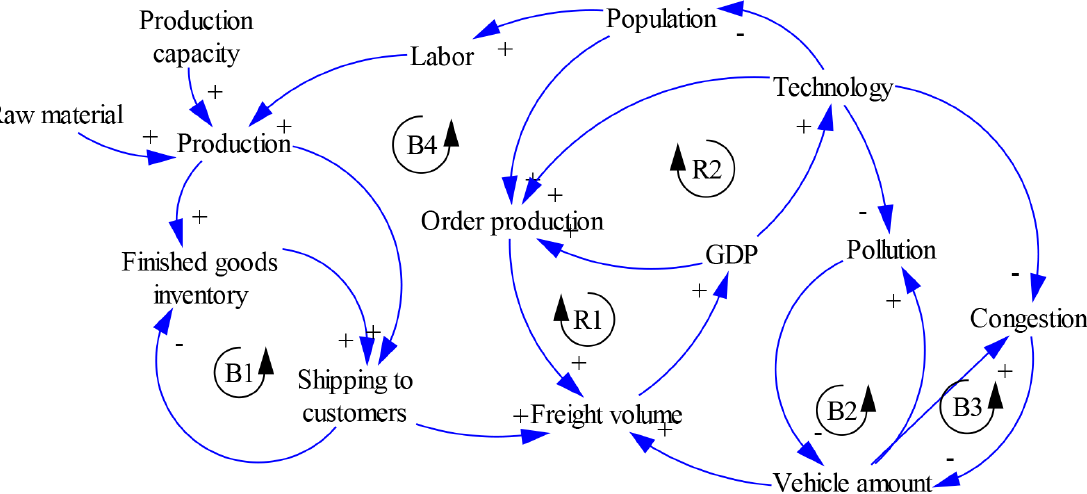
Figure 3. Causal loop diagram of SD